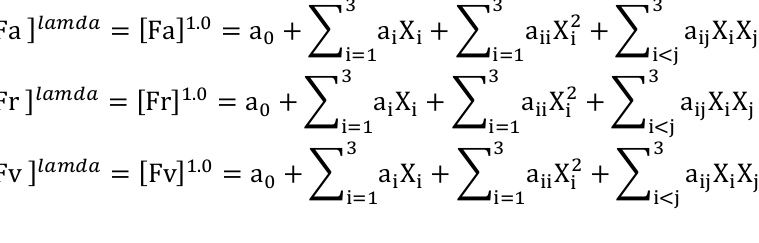
(b) Analysis of variance for